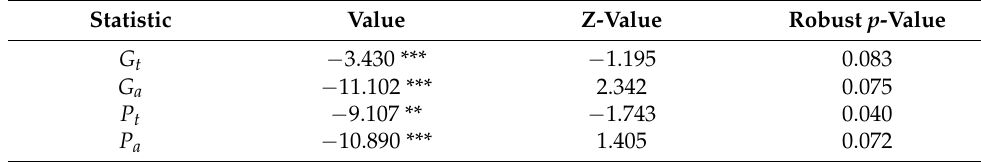
Table 7. Westerlund co-integration test